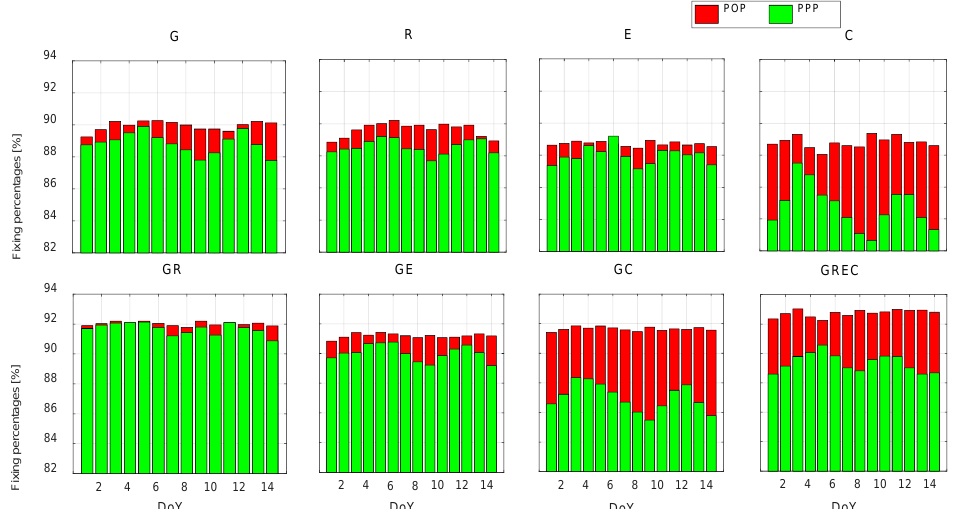
Figure 4. The fixing percentages of PPP and POP AR with 14 days of single-, dual- and four-system observations. By doing a chi-squared distribution test with a 0.05 level of significance, it is shown that the p-value that indicates the significance-level for the differences between PPP and POP calculated with GLONASS, Galileo, BDS, GR, GE, GC and GREC observations is 0.062, 0.078, 0.0030, 0.25, 0.09, 0.0036 and 0.019, respectively, with respect to GPS. We can see there are significant differences between the PPP and POP results with BDS, GC, and GREC observations.